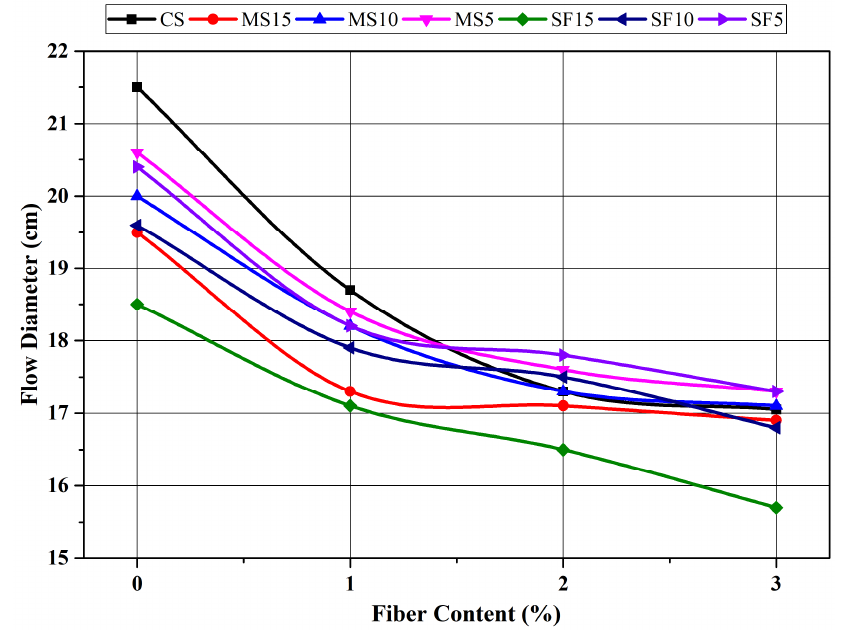
Figure 4. Flow diameter values of the mortar samples